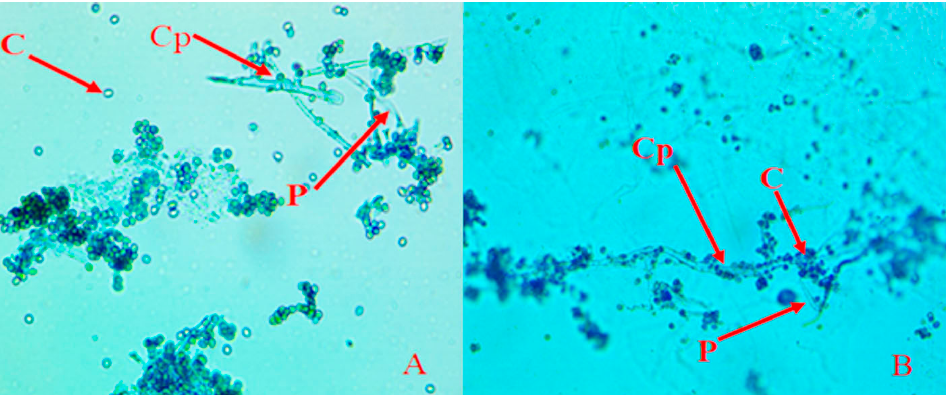
Fig. 1. Growth of isolates (A) T. asperellum and (B) T. viride